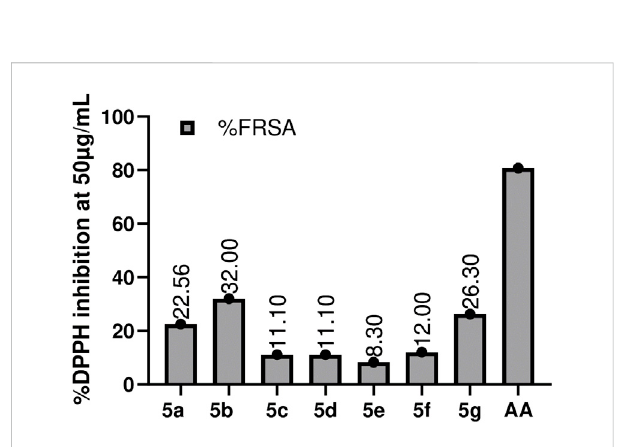
FIGURE 5 Graphical representation of DPPH Assay estimation of the synthesized compounds (5a-5g). Values given are expressed as the mean of triplicate ±standard